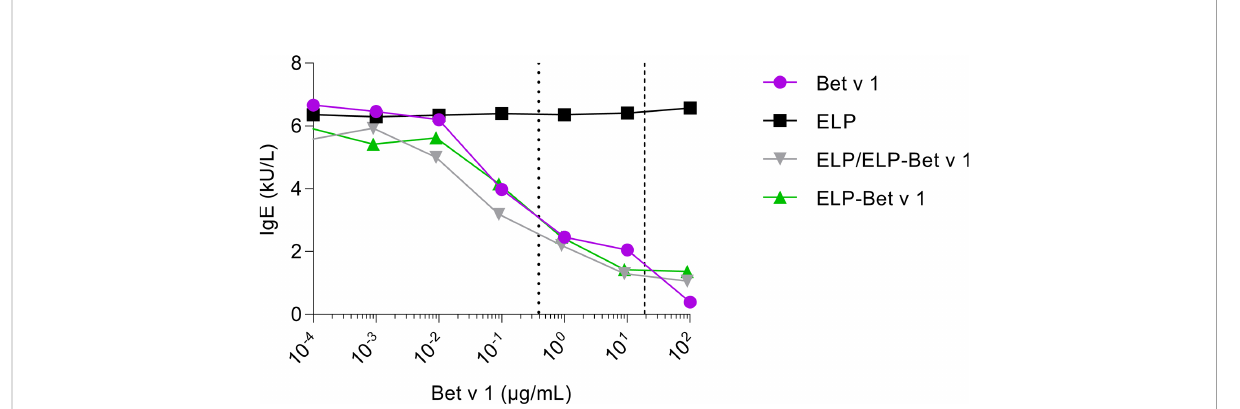
FIGURE 5 Inhibition of IgE binding to immobilized Bet v 1. ELP, Bet v 1, ELP-Bet v 1 and ELP/ELP-Bet v 1 were incubated at various concentrations with serum from birch pollen allergic patients containing Bet v 1-speci fi c IgE. The mixtures were subsequently applied to rBet v 1 ImmunoCAPs containing immobilized Bet v 1. Next, the IgE levels in the eluted solutions were measured. The dashed and dotted lines indicate the CMC of ELP/ELP-Bet v 1 (0.39 µg/mL) and ELP-Bet v 1 (19 µg/mL),